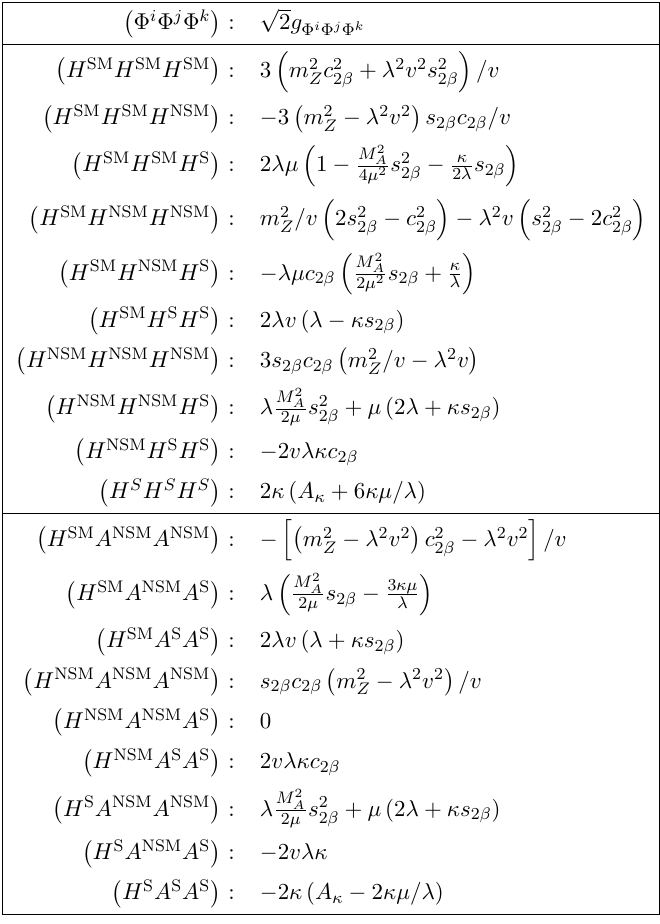
Table 6 . Trilinear couplings in the NMSSM Higgs sector in the extended Higgs